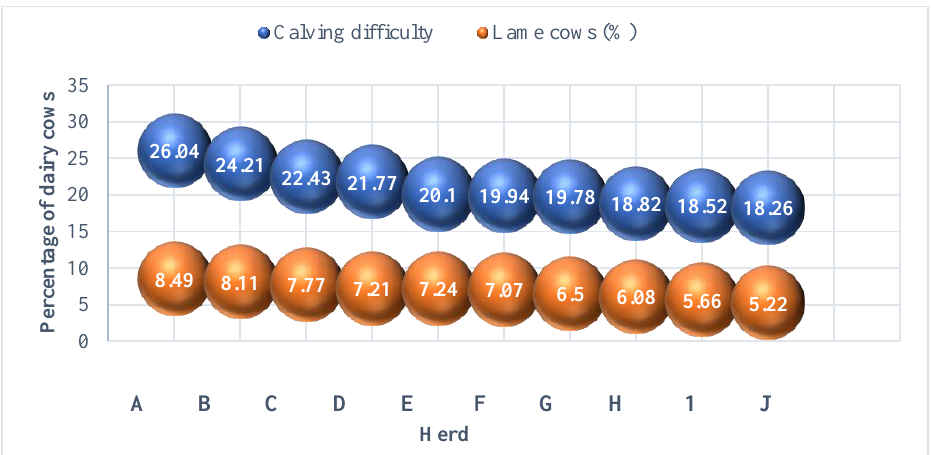
Figure 1. Percentage of dairy cows with dystocia at calving and lameness from 1 to 30 days after calving in different herds. A – J — Herd. Table 2. Distribution of cows by lameness and calving difficulty. Lameness Score